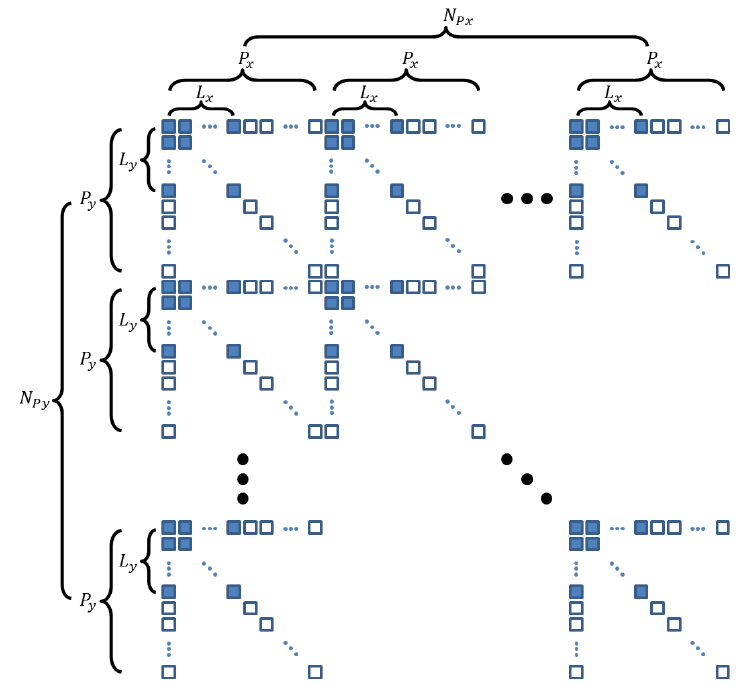
Figure 2. Sparse rectangular array layout. The array comprises N Px ∙ N Py blocks. In each block having P x ∙ P y elements, only the two-dimensional (2D) subarray consisting of L x ∙ L y elements (blue colored squares) is active.